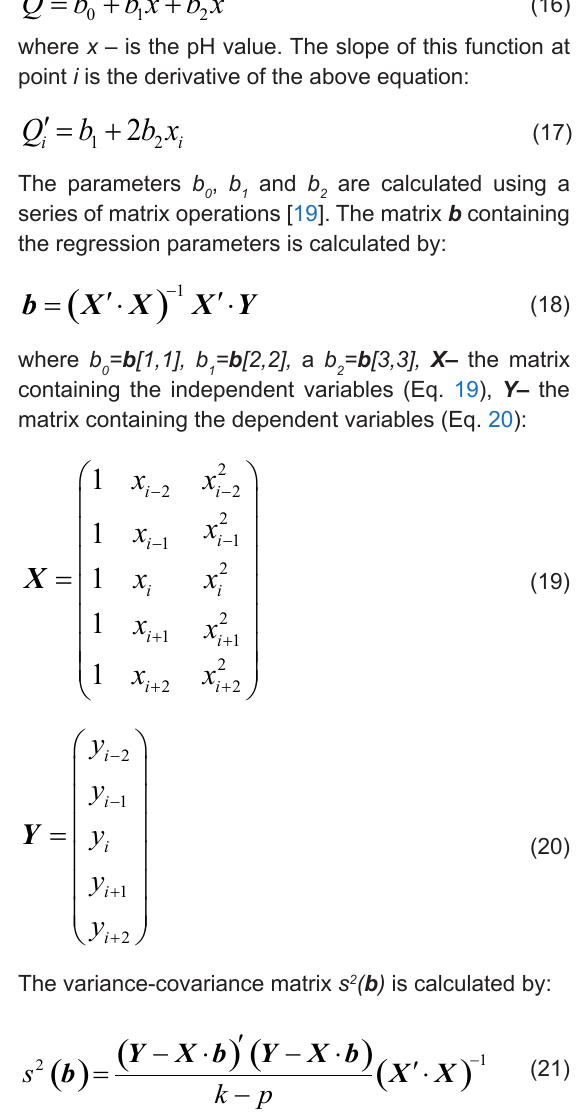
where the variance V() and covariance Cov() values are obtained from s 2 ( b )